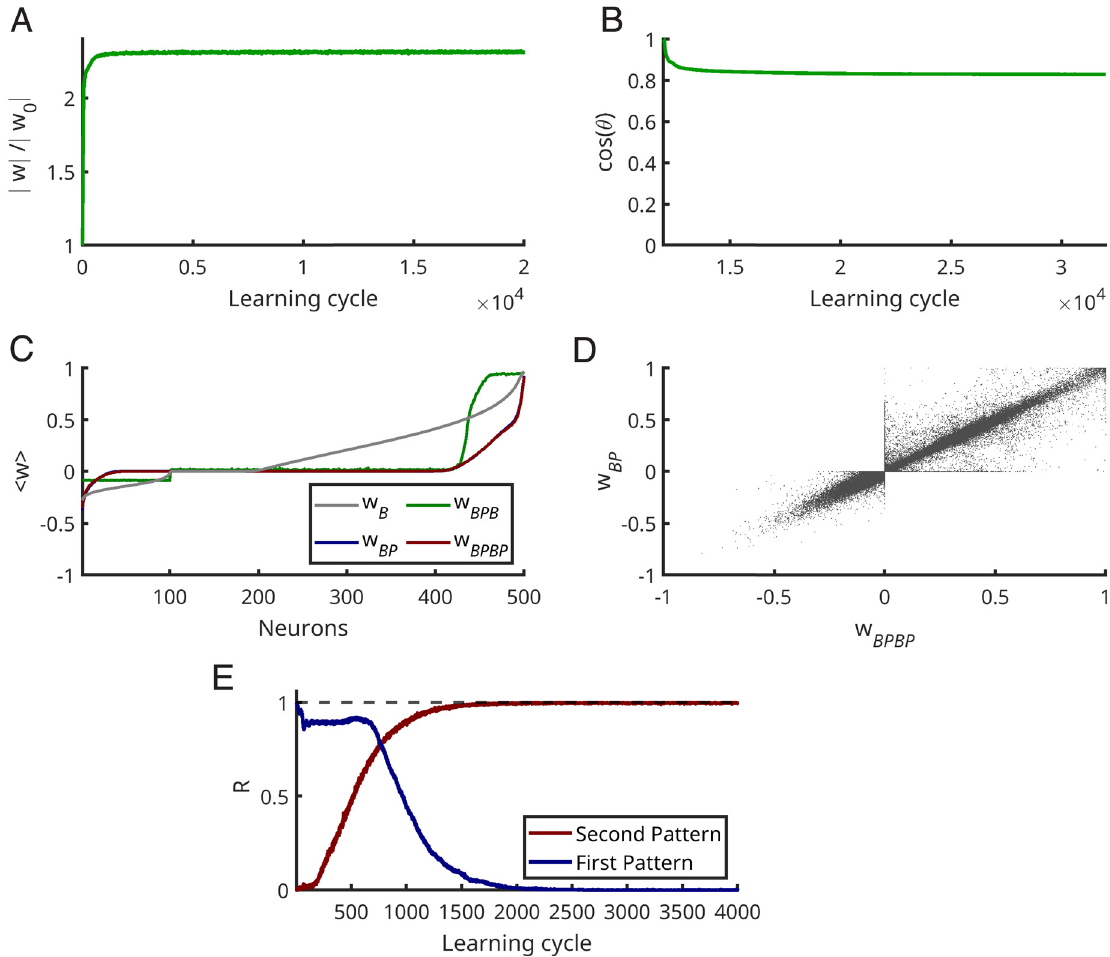
Fig 5. Stability of memory. (A, B) Without learned patterns in afferents, learning continues. (A) Average of the ratio of the norm of the current weight vector divided by the norm of the learned pattern weight vector (w 0 ). (B) Average of the cosine between the current weight vector and w 0 . (C) Average of weight values in each stage of learning: First neurons learned to fire 2 Hz while there is no embedded pattern in afferents till the learning cycle 2000. W B (gray line in (C) ) is the average of sorted weights for this case. Then in each simulation an embedded pattern is present in the afferents for 10000 learning cycles. W (blue line) is the mean of sorted weights obtained after neurons BP learned the embedded patterns. Next there is again no embedded pattern in afferents for 20000 learning cycles, and W BPB shows the resulting weight vector at this learning cycle, however, displayed using the ranks from W . Finally, there is again the original embedded BP pattern in the afferents for further 20000 learning cycles; W shows the resulting averaged weights with the same sorting. In the mean BPBP the sorting is conserved, and the values return to the same size. (D) The scatter plot from all simulations demonstrates that most of the weights remain roughly the same, i.e. learning a pattern leads to a fixed point in weight space. (E) The neurons first learn the first embedded pattern for the 10000 learning cycles, and then there is another different embedded pattern (second pattern) in afferents for another 10000 learning cycles. This figure shows the R-value for the second 10000 learning cycles. This figure is based on an average of 500